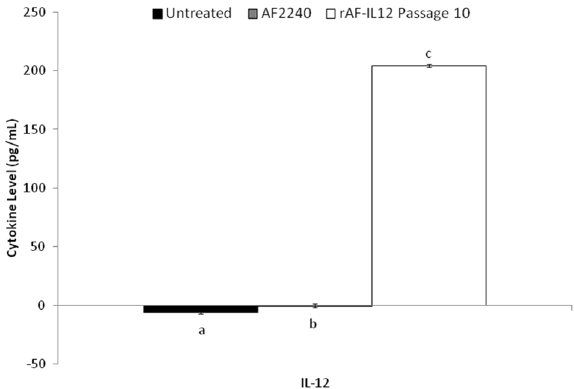
Figure 5. ELISA-based detection of IL-12 levels in the serum of the control (untreated), NDV AF2240- and rAF-IL12 passage 10-treated mice groups. Each value represents the mean values ± S.E.M for n = 9 mice per group. The values are expressed as the mean values ± standard deviation of triplicate experiments. The mean values as indicated using different superscript letters were significantly different at p < 0.05 when compared between parental AF2240- and rAF-IL12 (Passages 1, 5 & 10)-treated